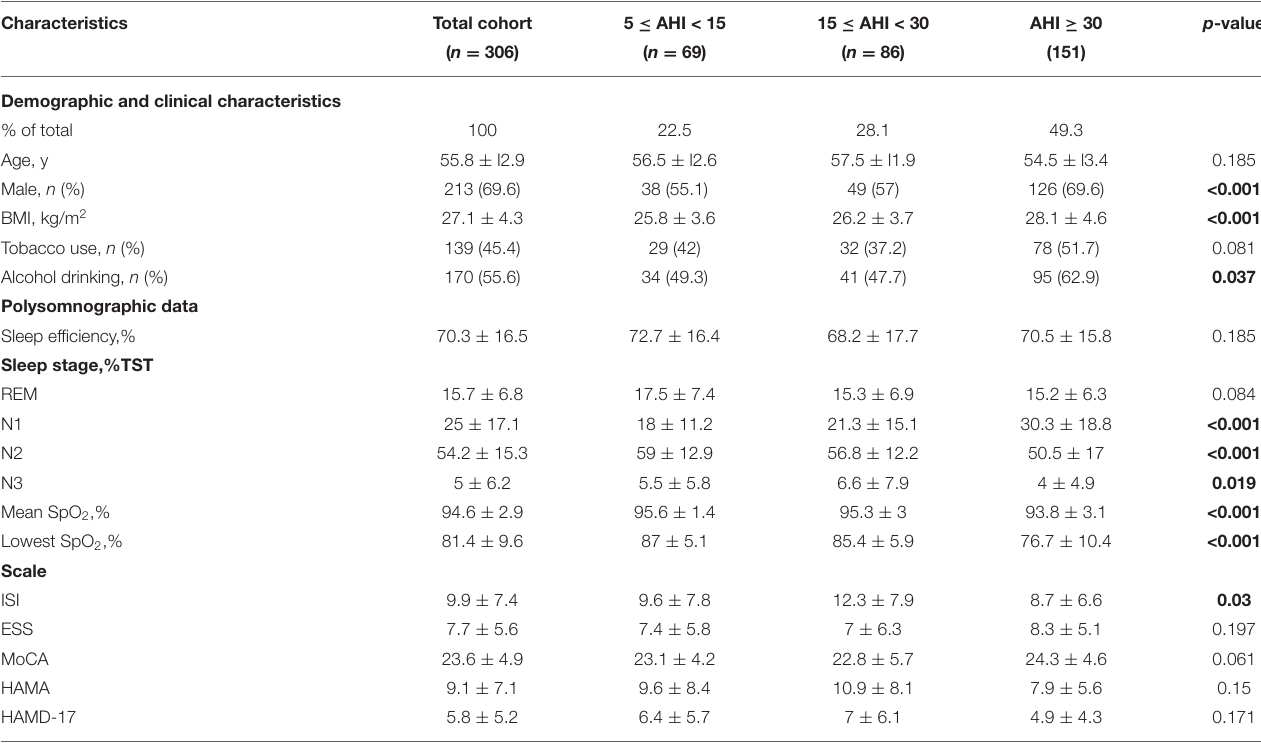
TABLE 1 | Characteristics of the patients according to the severity of OSA.